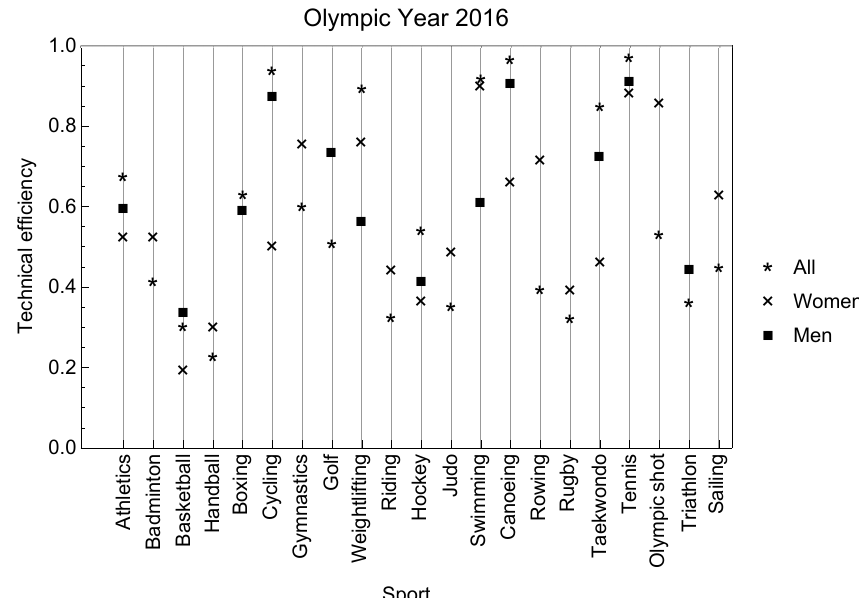
Figure 4. Technical efficiency (Olympic year